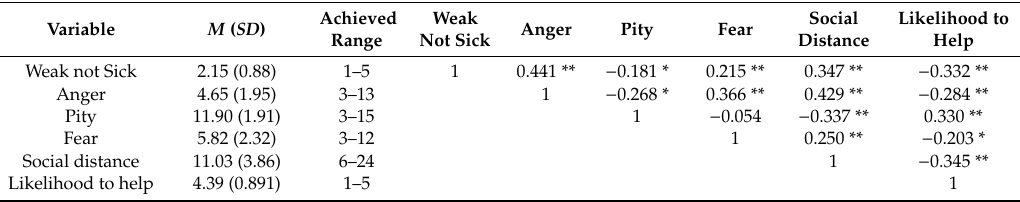
Table 2. Descriptive details for, and correlations between, key variables.